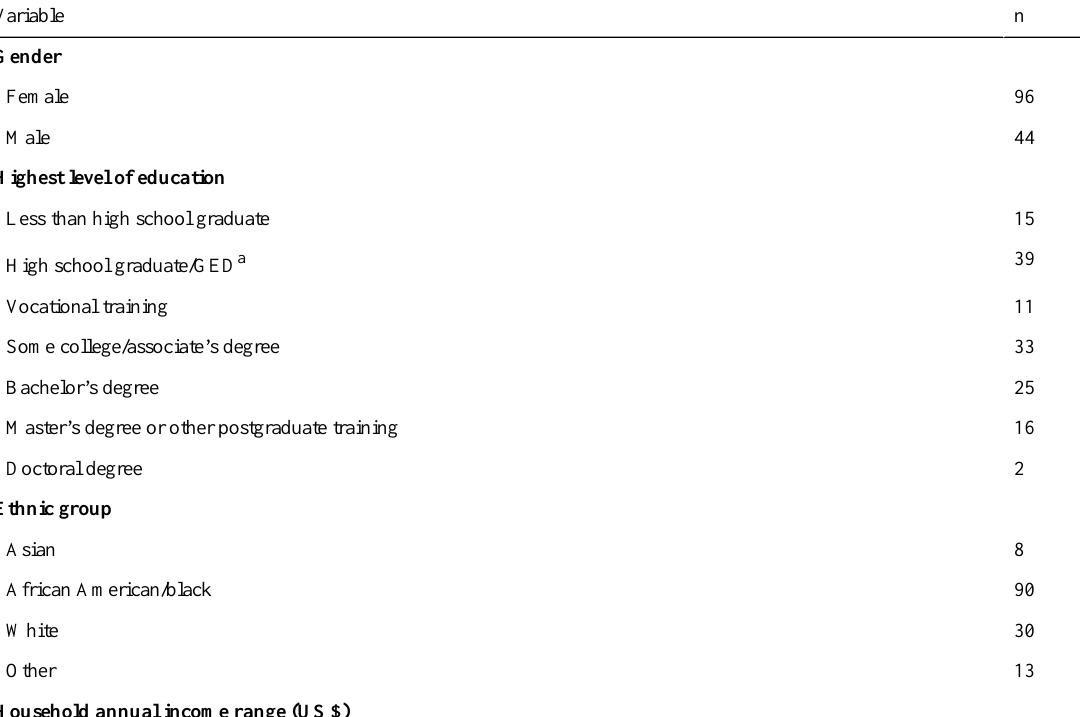
Table 1. Participants’basic